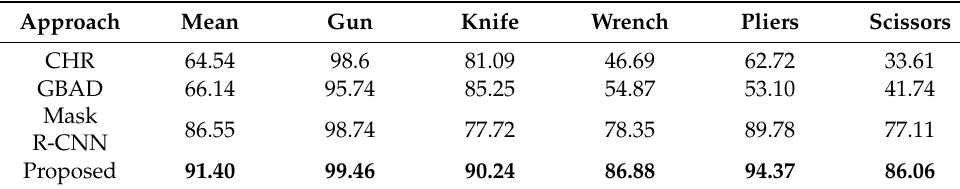
Table 5. Classification mean average precision (%) for SIXray100.